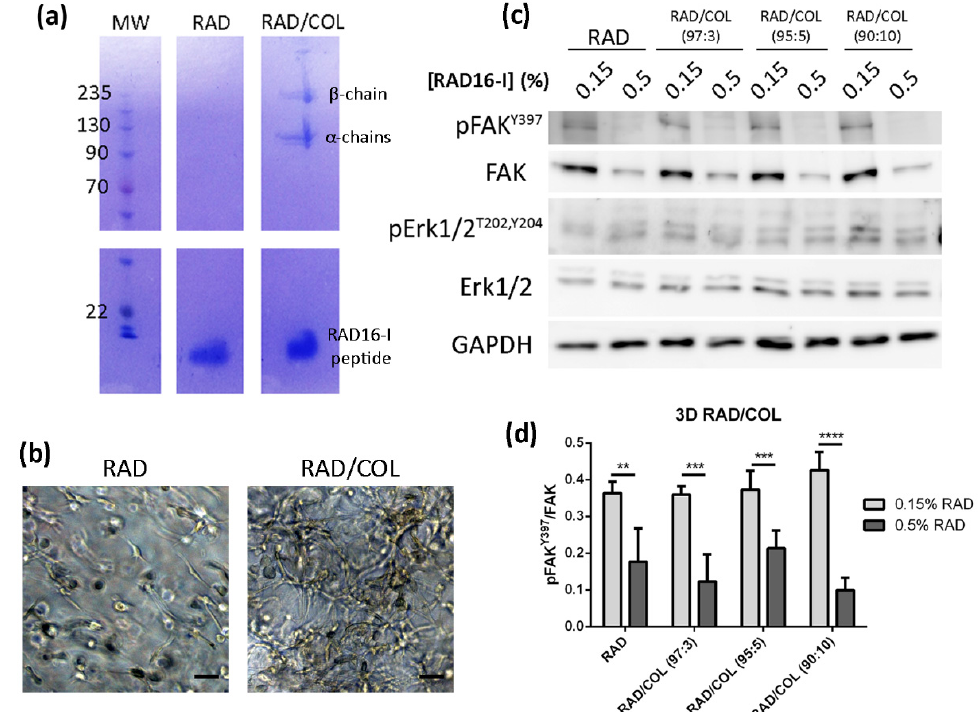
Figure 5. Cell culture in RAD16-I matrix functionalized with collagen type I. ( a ) SDS-PAGE of RAD or RAD/COL cell-free gels; ( b ) phase-contrast microscopy images of fibroblast 24 h after cell embedding within 0.15% RAD or RAD/COL gels. Scale bars represent 50 µ m; ( c ) Western blot bands of FAK and Erk1/2 and its phosphorylated forms in PANC-1 cells cultured in 0.15% (soft) and 0.5% (stiff) RAD16-I gels mixed with increasing amounts of collagen I; ( d ) densitometry of pFAK Y397 /FAK shown in ( c ). GAPDH was used as loading control. Statistical differences are indicated as ** for p value < 0.01, *** for p value < 0.001 and **** for p value < 0.0001.